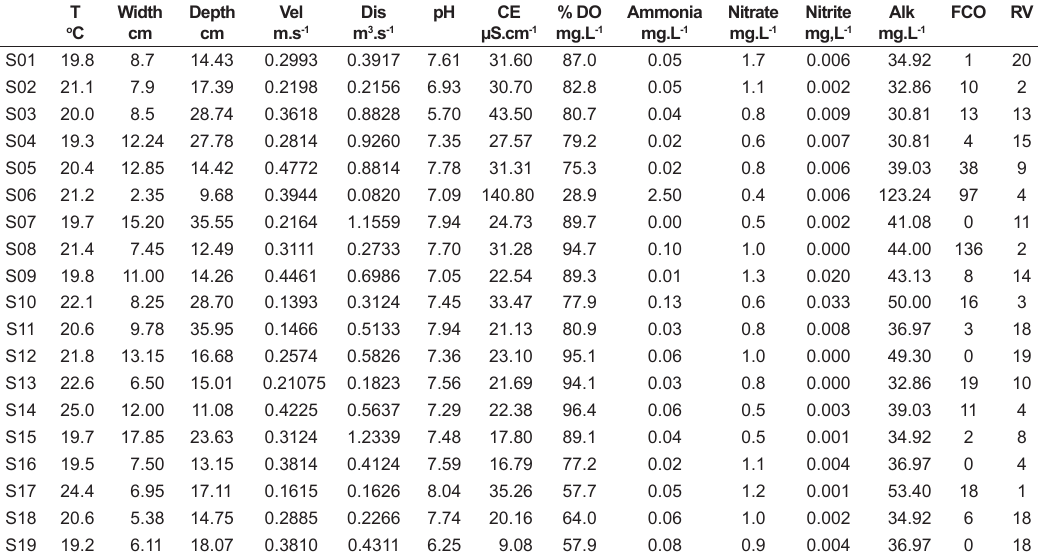
Table 2. Environmental features measured for 19 rivers studied in Serra da Bocaina Mountains. T o C